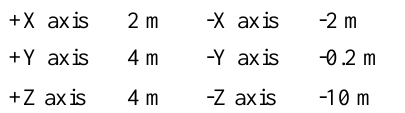
Dimensions of computational